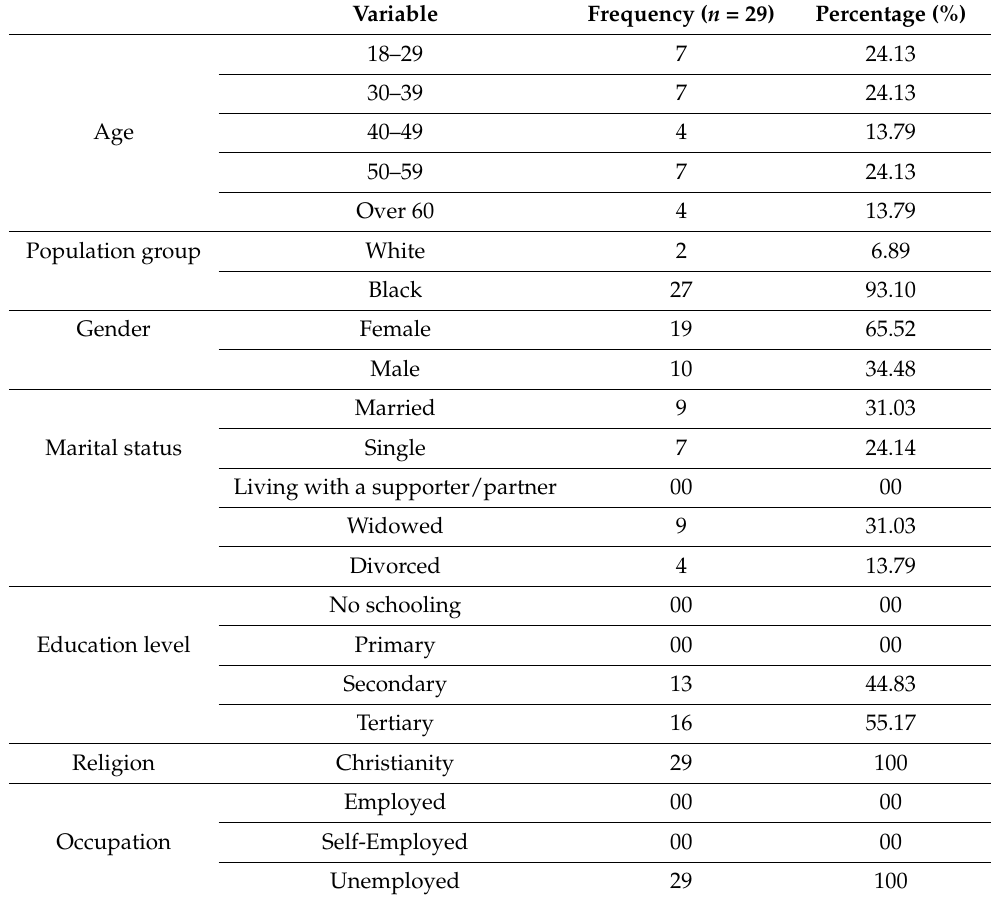
Table 1. Characteristics of the study participants in O.R. Tambo District